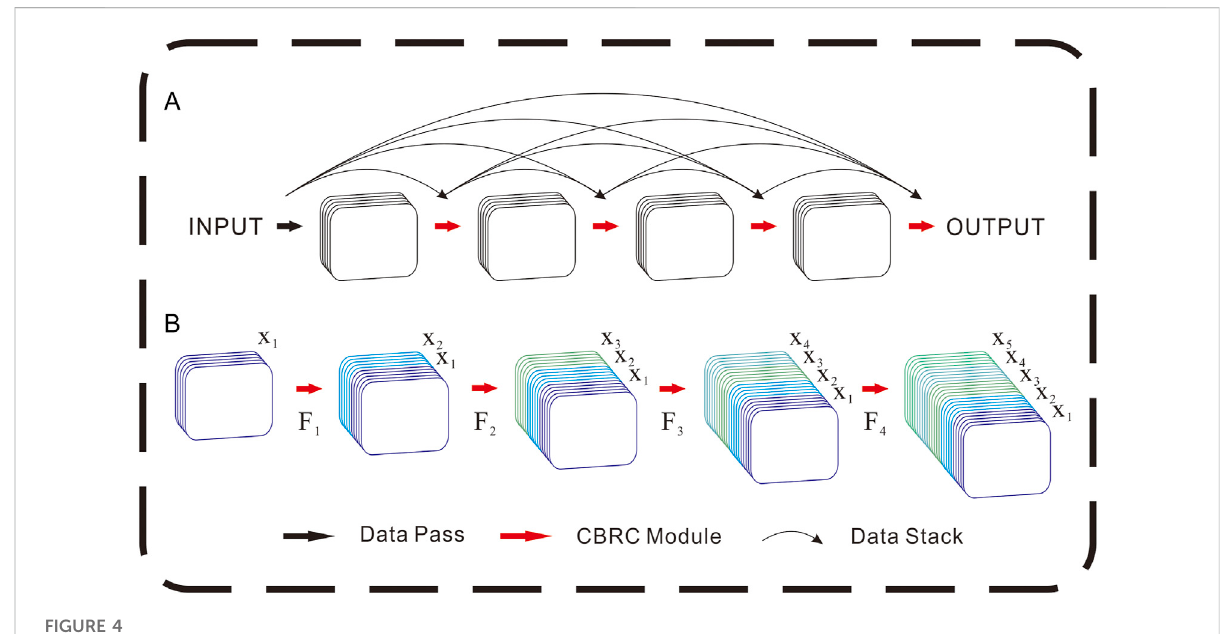
FIGURE 4 Dense block mechanism (A) and its details of data shape growth (B)